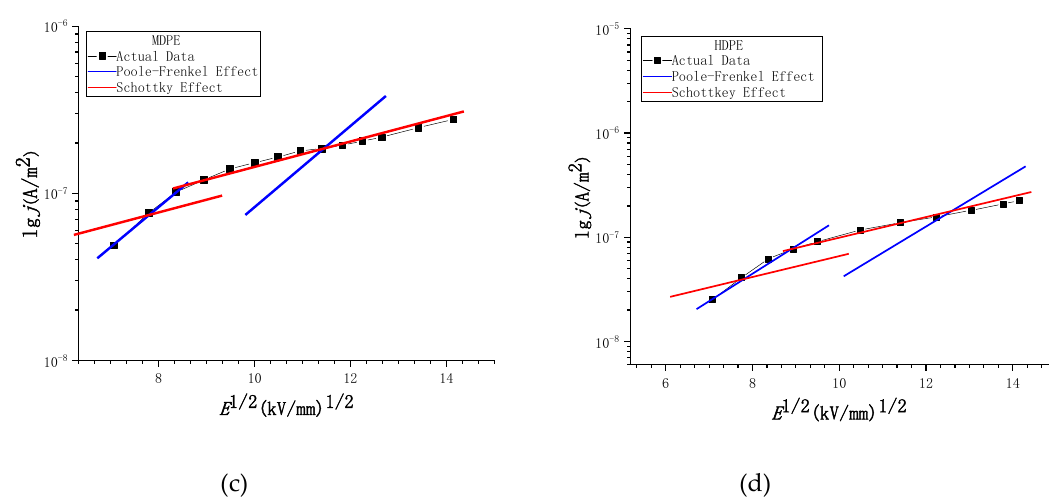
Figure 8. Fitting curve of the four kinds of polyethylene in ln j - E 1/2 coordinates: ( a ) Fitting curve of the LDPE in lnj-E1/2 coordinates; ( b ) Fitting curve of the LLDPE in lnj-E1/2 coordinates; ( c ) Fitting curve of the LDPE in lnj-E1/2 coordinates; ( d ) Fitting curve of the LDPE in lnj-E1/2 coordinates.